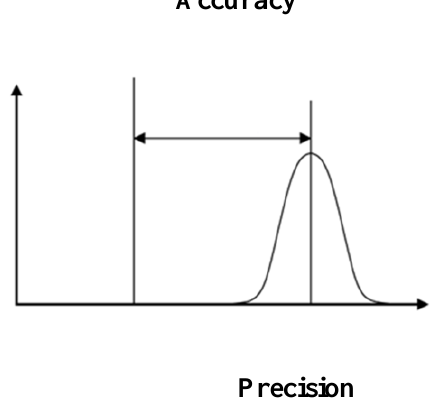
Figure 2. Illustration of Accuracy and Precision Parameters.